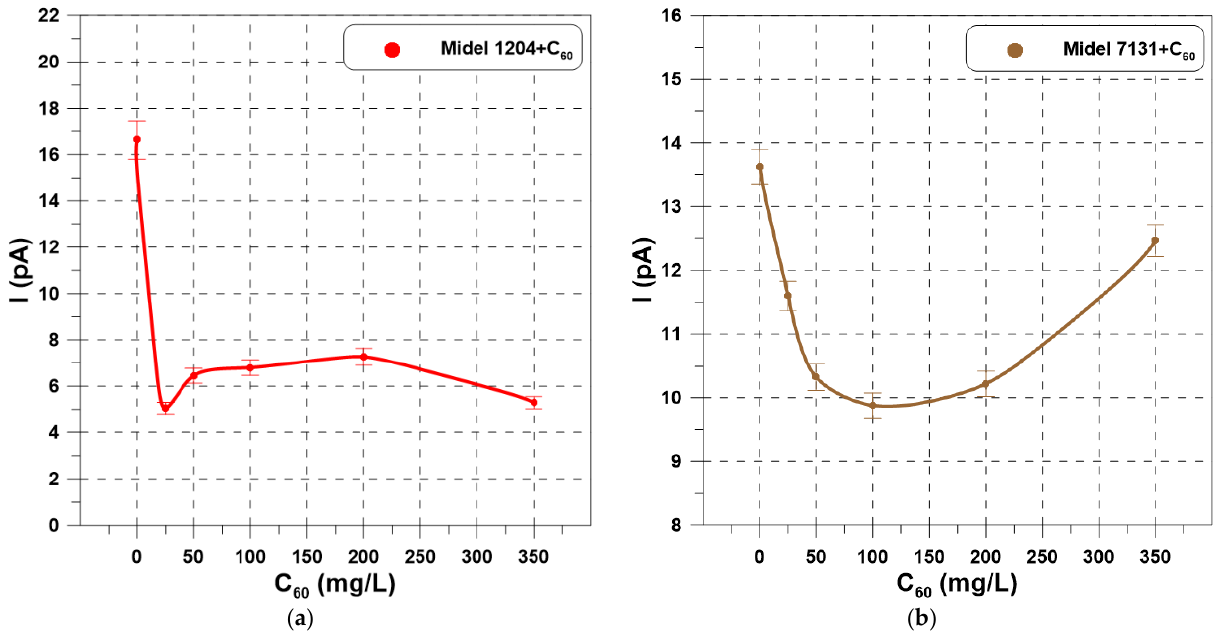
Figure 6. Electrification current of ( a ) Midel 1204 natural ester and ( b ) Midel 7131 synthetic ester versus concentration of C 60 ( v = 0.34 m/s, T = 20 °C).